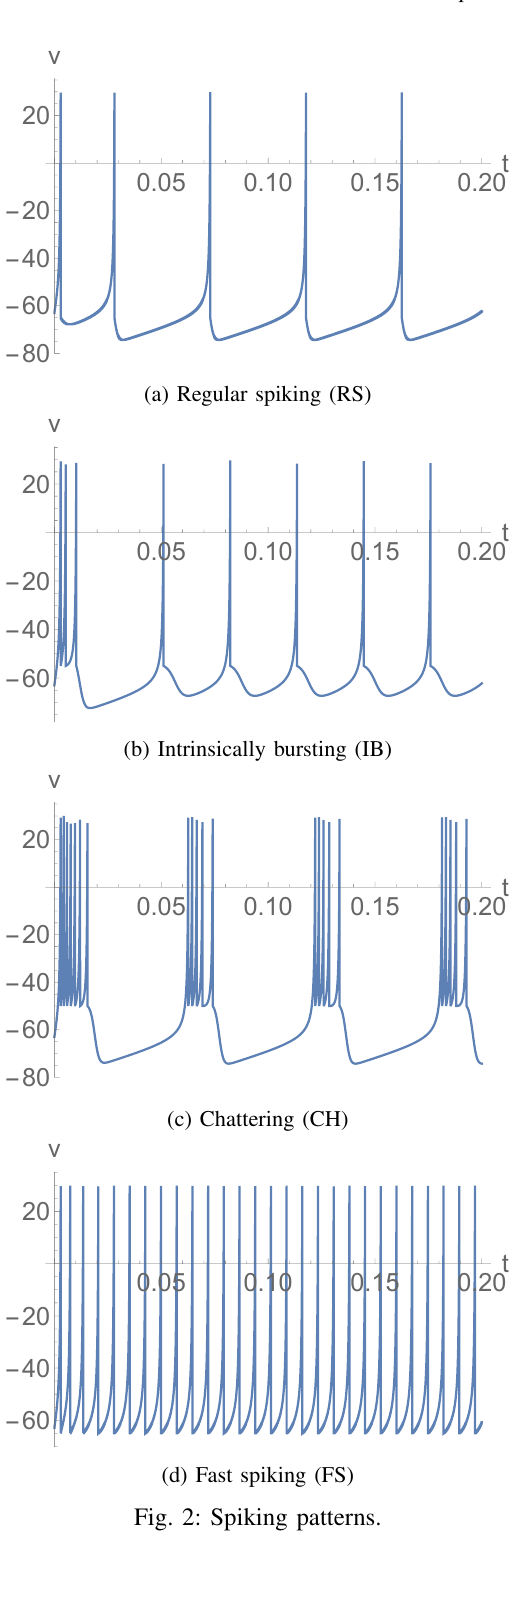
Fig. 2: Spiking patterns.